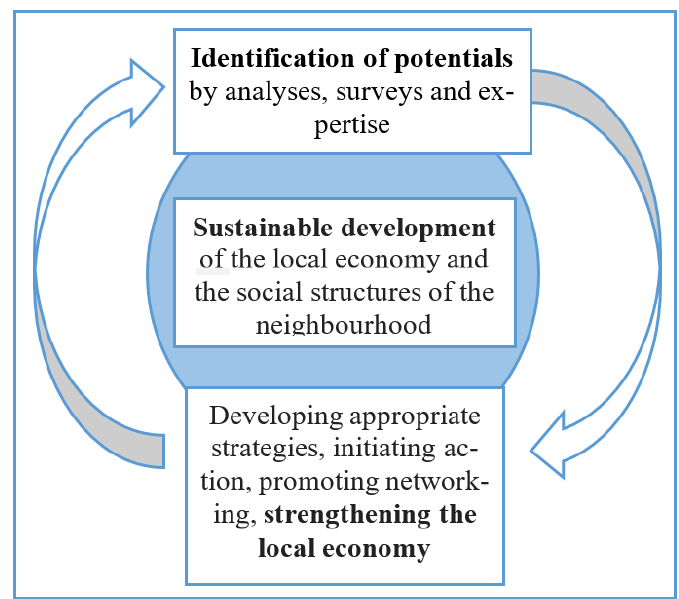
Figure 3: The project